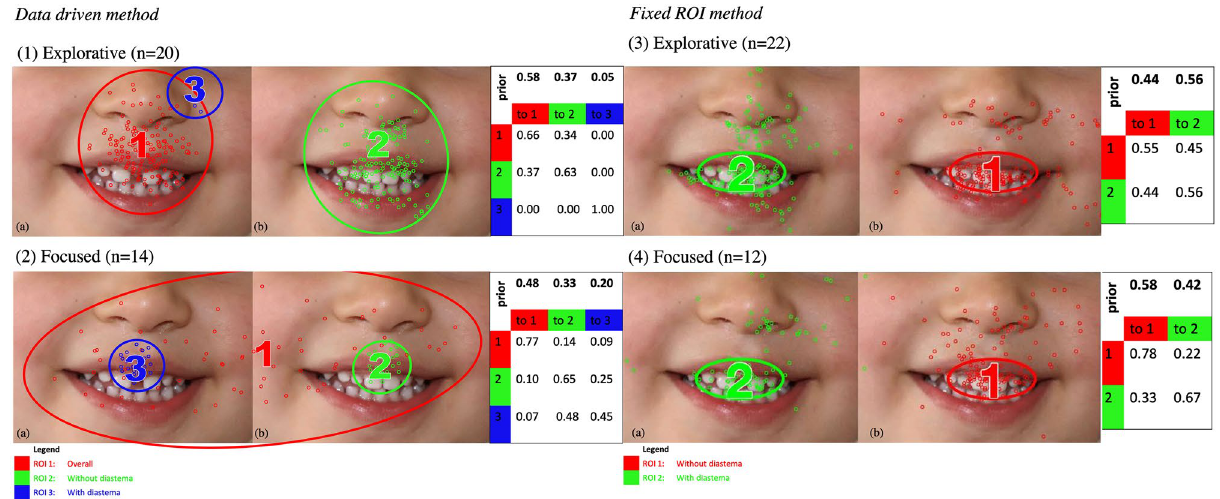
Figure 3. The educators exhibited two different eye movement patterns: (1) explorative pattern, where the ROIs were predominantly around the nose and mouth, and (2) focused pattern, where the ROIs were mainly on the teeth. Fixed ROI method: illustrates the two fixed teeth-focused ROIs and the two different eye movement patterns identified in educators using the fixed ROI method. (3) Explorative pattern, where participants tended to switch between the two images more often. (4) Focused pattern, where participants tended to view the same image longer before switching to the other image. The ROIs are defined as elliptical areas in the mouth region and represented as ROI1: without diastema and ROI2: with diastema. Ellipses show two standard deviation contours from the mean of the ROIs (2D Gaussian distributions). Small circles in different colours show the assignment of raw fixations to different ROIs. The table shows transition probabilities among the ROIs. Priors show the probabilities that a fixation sequence starts from an ROI. For example, in the fixed ROI explorative pattern (3) group, educators had a 44% chance of starting fixations in ROI1 and a 56% chance of starting in ROI 2. After that, they remained in the same ROI (ROI1 = 55%, ROI2 = 56%) or switched ROI (ROI1 to ROI2 = 45% and ROI2 to ROI1 =